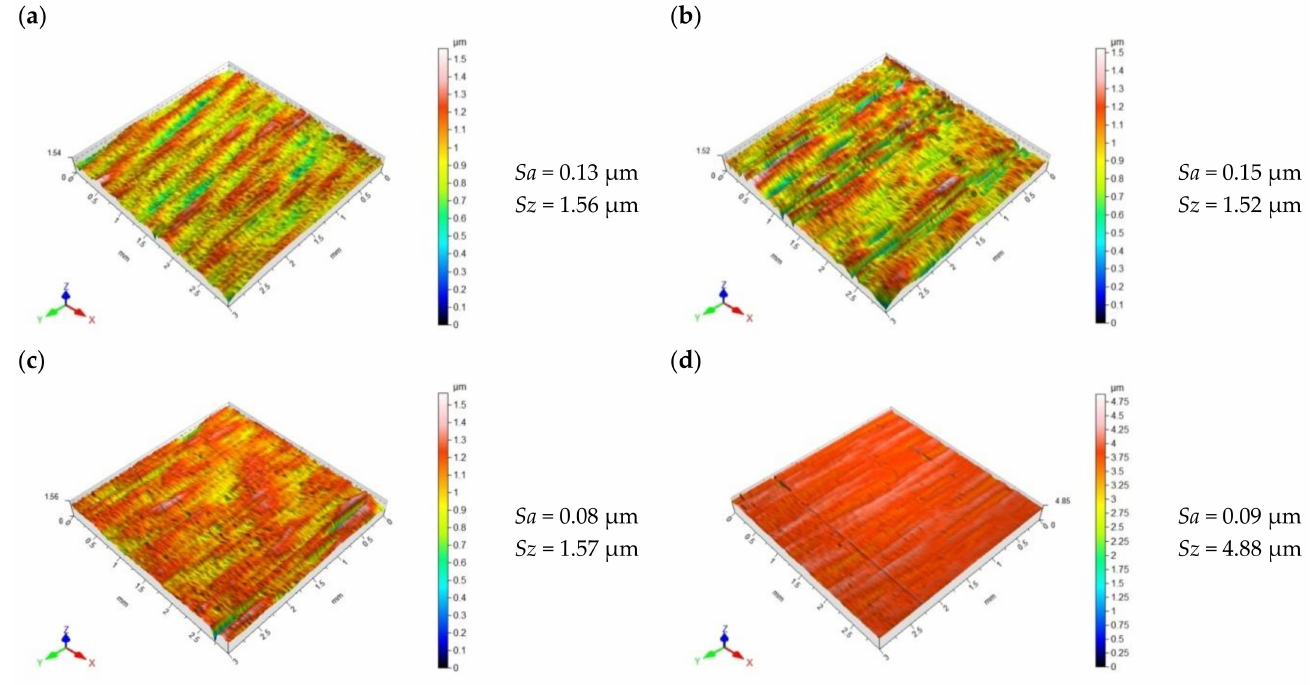
Figure 9. Topography of X6CrNiTi18 steel surface after slide burnishing ( a ) F = 90 N, f = 0.06 mm/rev.;